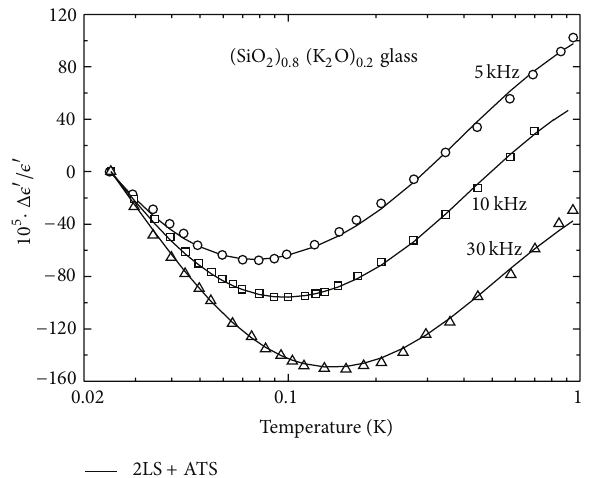
Figure 9: Dielectric signature of mixed ( SiO 2 ) 1−𝑥 ( K 2 O ) 𝑥 glasses as function of 𝑇 and 𝜔 for 𝑥 = 0.2 [24]. Fitting parameters from Table 1 using (8) and (14) from our theory.